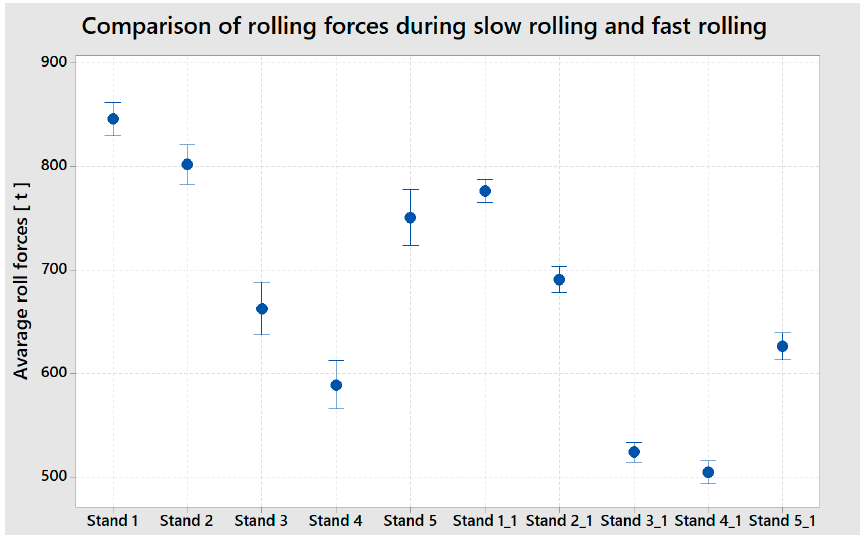
Figure 11. Comparison of rolling forces slow rolling (Stand 1, 2, 3, 4, 5,) and fast rolling (Stand 1_1, 2_1, 3_1, 4_1, 5_1). Materials 2020 , 13 , x FOR PEER REVIEW